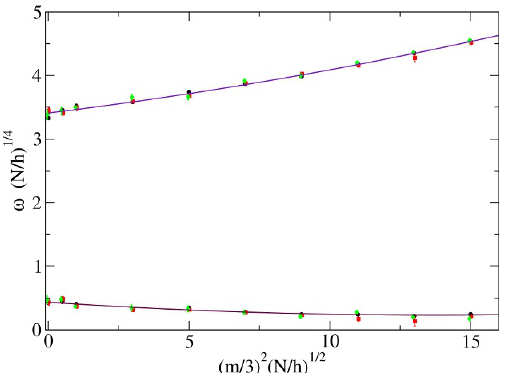
Figure 6 . The curves of ! for the lowest quasinormal mode of E h , obtained from in(cid:13)ation-type quenches. The parametrization of the axis is explained in the main text. The color code is black N = 10, red N = 15, green N = 20. (Data have been slightly shifted horizontally to improve the